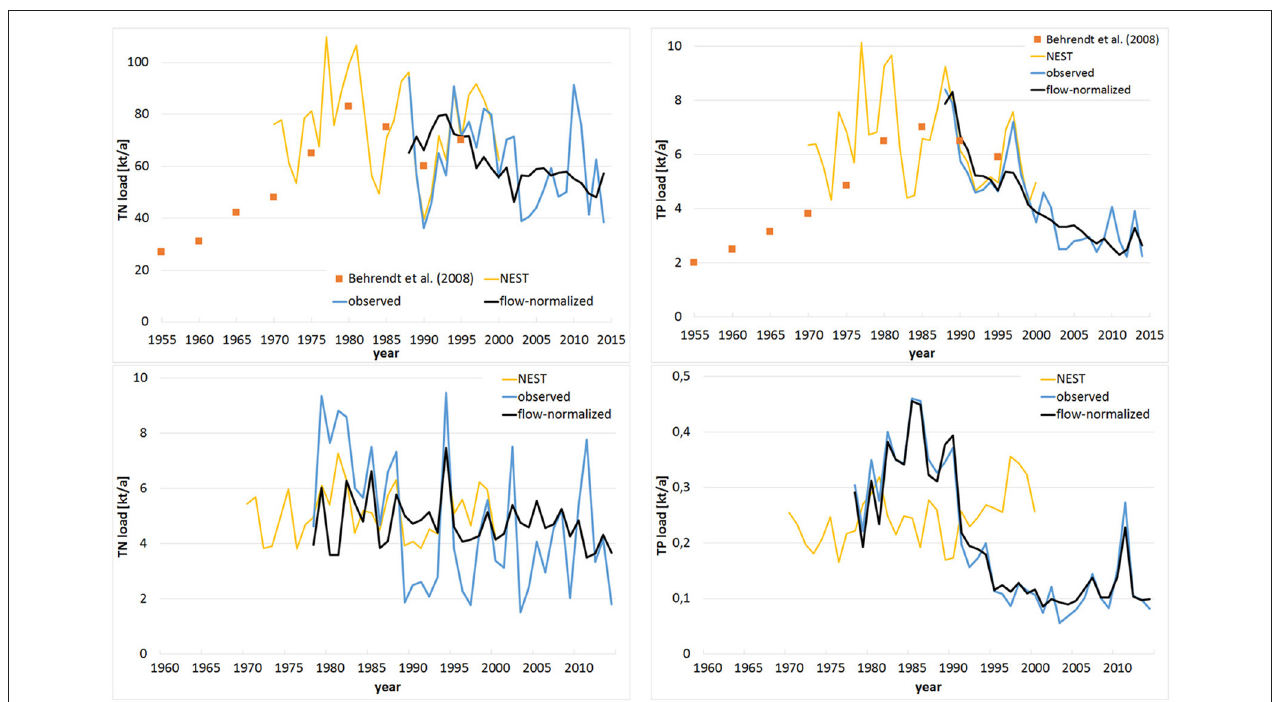
FIGURE 3 | Annual total nitrogen (TN) and total phosphorus (TP) loads discharged by Oder (Upper) and summed for Peene, Uecker and Zarow (Lower) based on observations (blue) and flow-normalization (black); supplemented by reconstructed loads from Baltic Nest Institute (yellow; Wulff et al., 2013) and Behrendt et al., 2008 (orange, only for Oder).